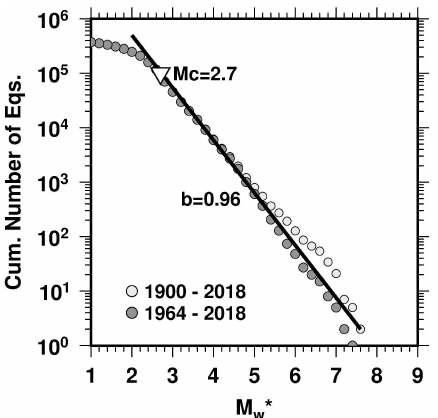
Figure 7. The Gutenberg–Righter frequency–magnitude distribu- tion for the homogenized catalogue. Light and dark grey circles rep- resent the cumulative number of earthquakes in the periods 1900– 2018 and 1964–2018, respectively. The b value and magnitude com- pleteness ( M c ) for the period of 1964–2018 are 0.96 and 2.7, respec-